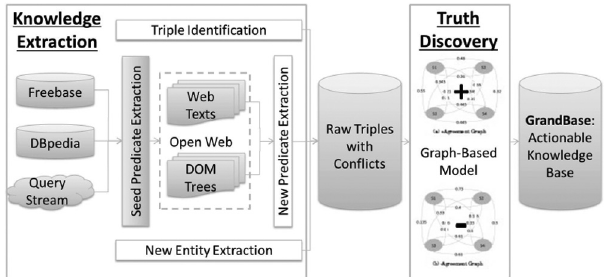
Figure 1. The framework of GrandBase construction: white rectangles with underlined labels represent the two main phases of GrandBase construction, the three small white rectangles inside the knowledge extraction rectangle depict the three tasks of knowledge